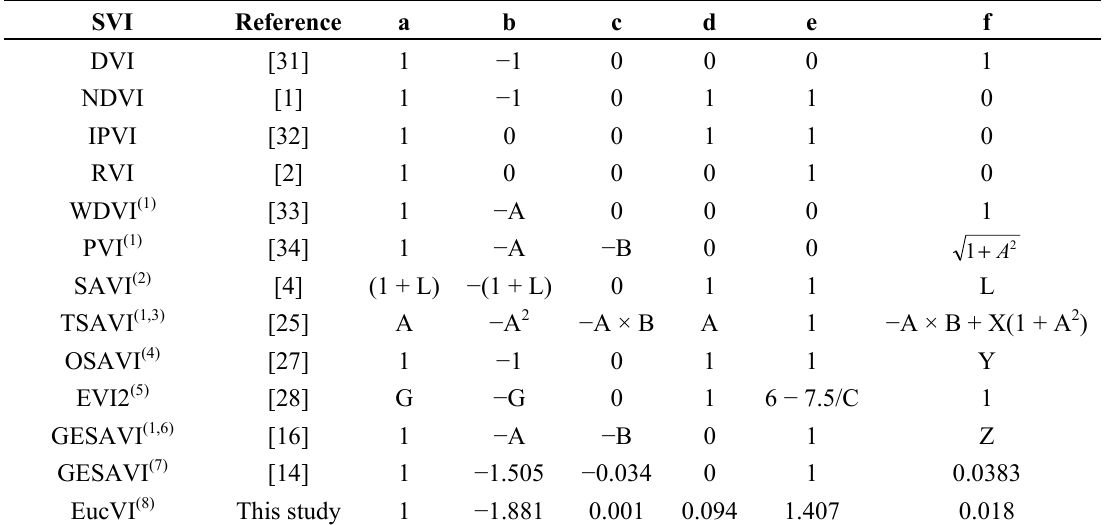
Table 2. Examples of classical 2-band (RED and NIR) spectral vegetation indices, and SVI calibrated for Eucalyptus (GESAVI cal and EucVI). Values of parameters [a, b, c, d, e,